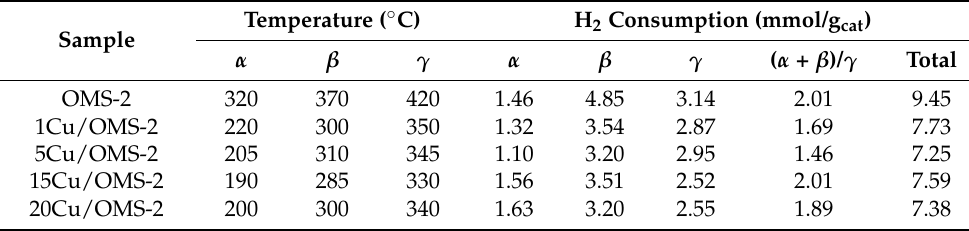
Table 3. Reduction temperatures and H 2 consumption of the OMS-2 and x Cu/OMS-2 samples.